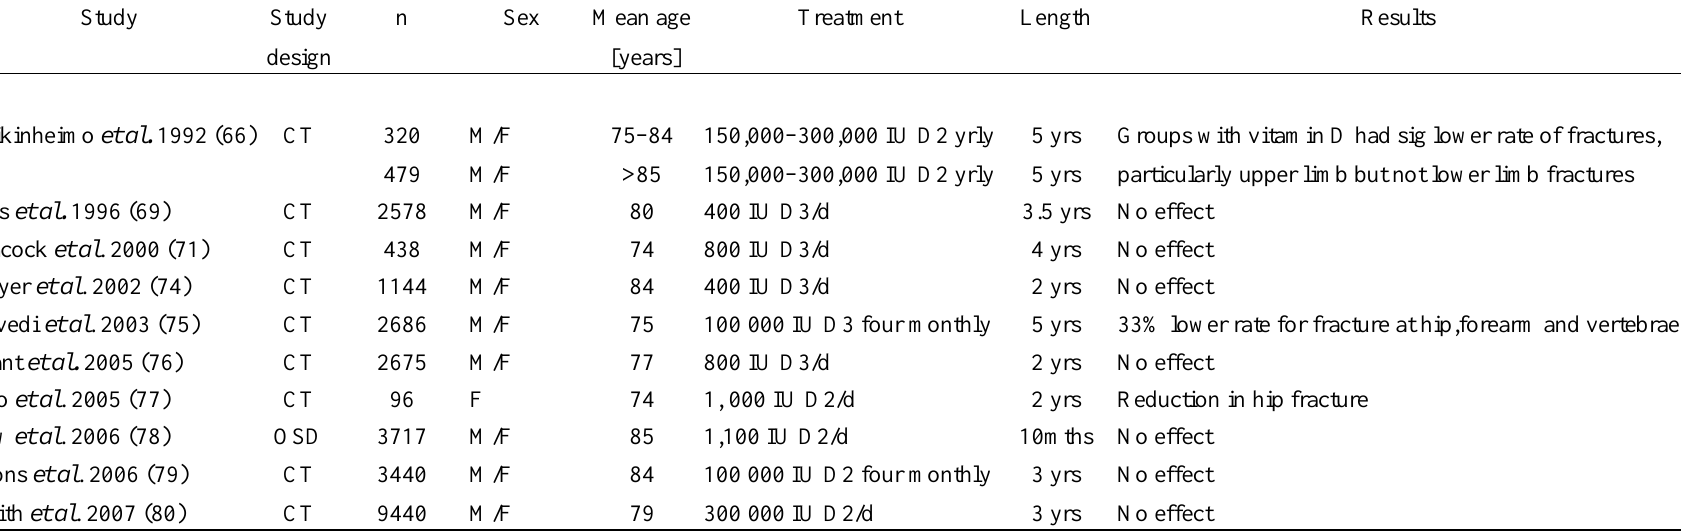
Table 1. Intervention with vitamin D on fracture